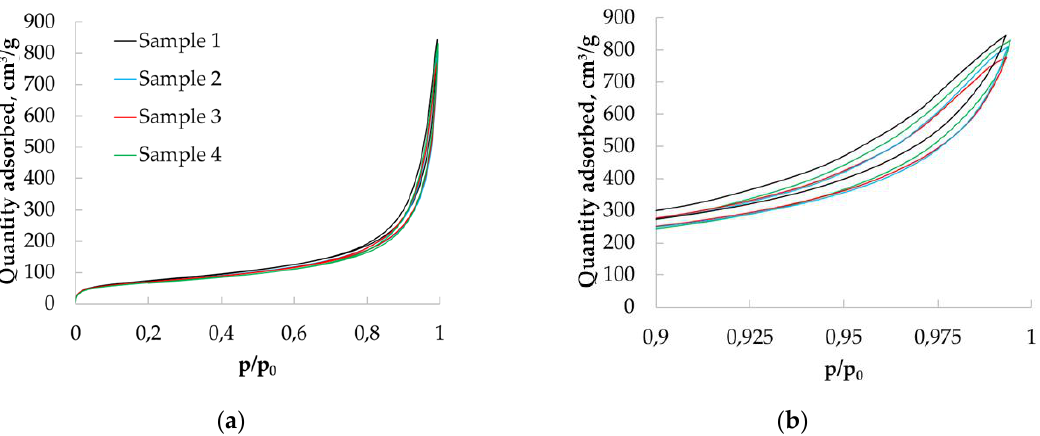
Figure 5. Nitrogen adsorption / desorption isotherms for chitosan-based aerogel particles: ( a ) in the range p / p 0 0–1.0; ( b ) in the range p / p 0 0.9–1.0.